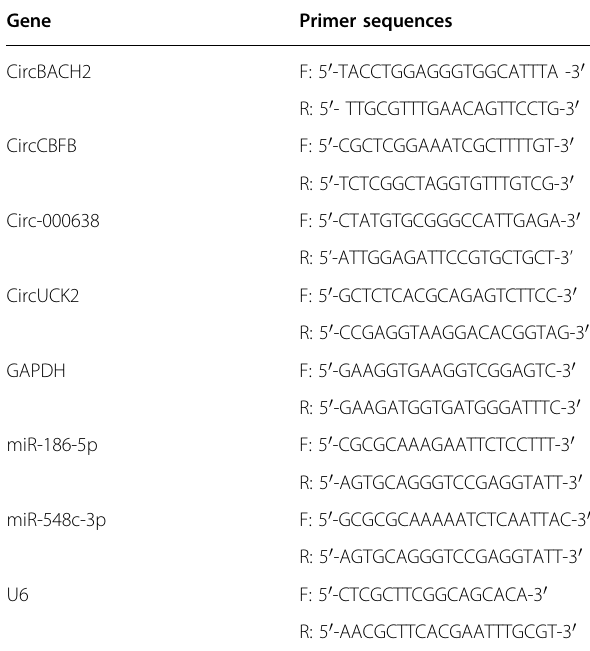
Table 2 Primer sequences for qRT-PCR. Gene Primer